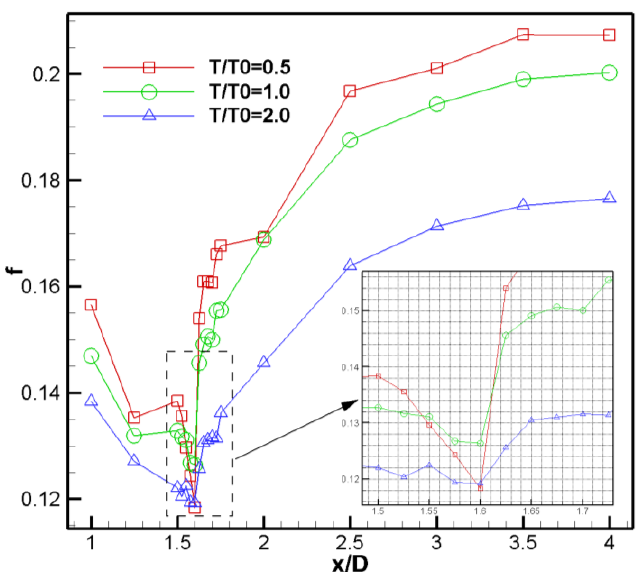
Figure 13. Coupling frequency varying with x / D .